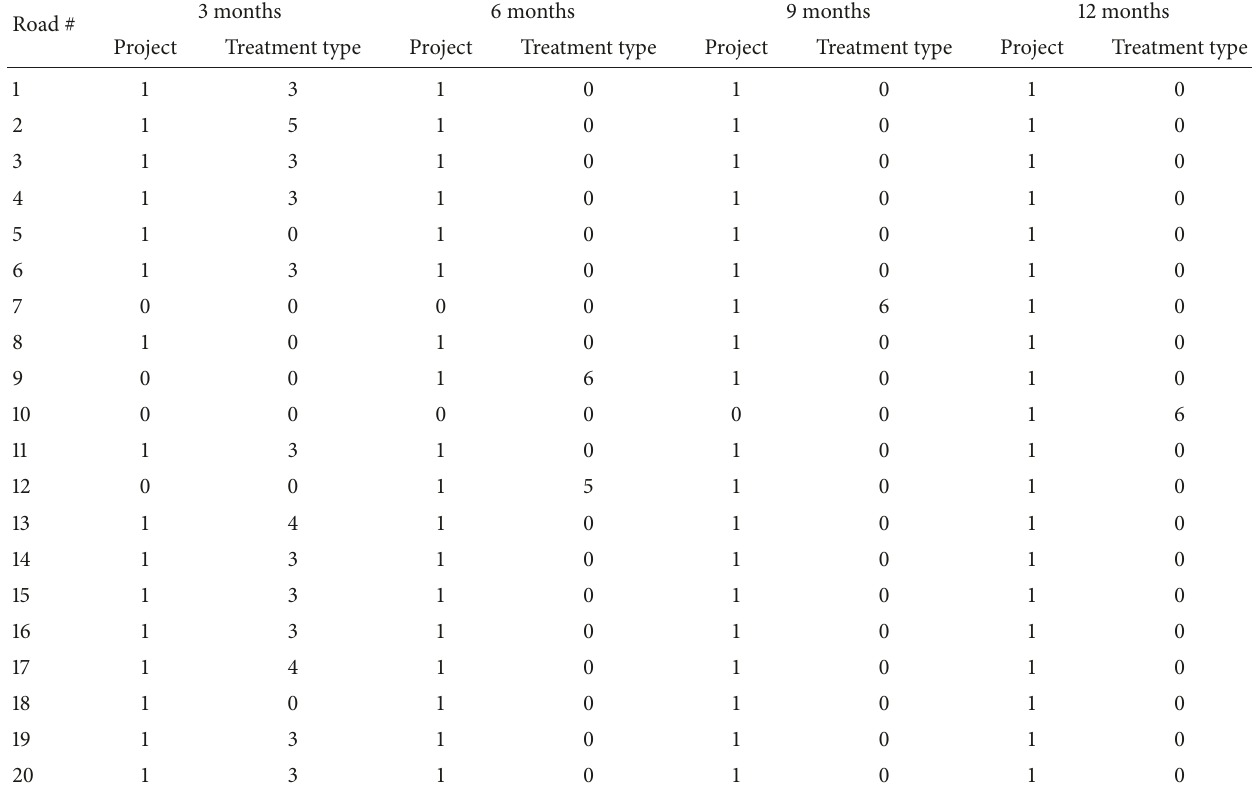
Table 8: Selected projects with treatment types for the entire